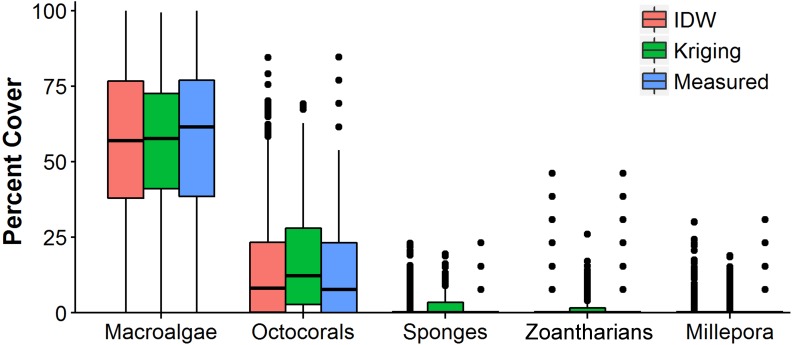
Comparison of the abundance values measured in situ of macroalgae, octocorals, sponges, zoantharians and Millepora alcicornis (millepora) of Madagascar reef, Gulf of Mexico, and those interpolated by Inverse Distance Weighting (IDW) and Ordinary Kriging during cross-validation.Box-plots represent four quartiles and median, with outliers as points.